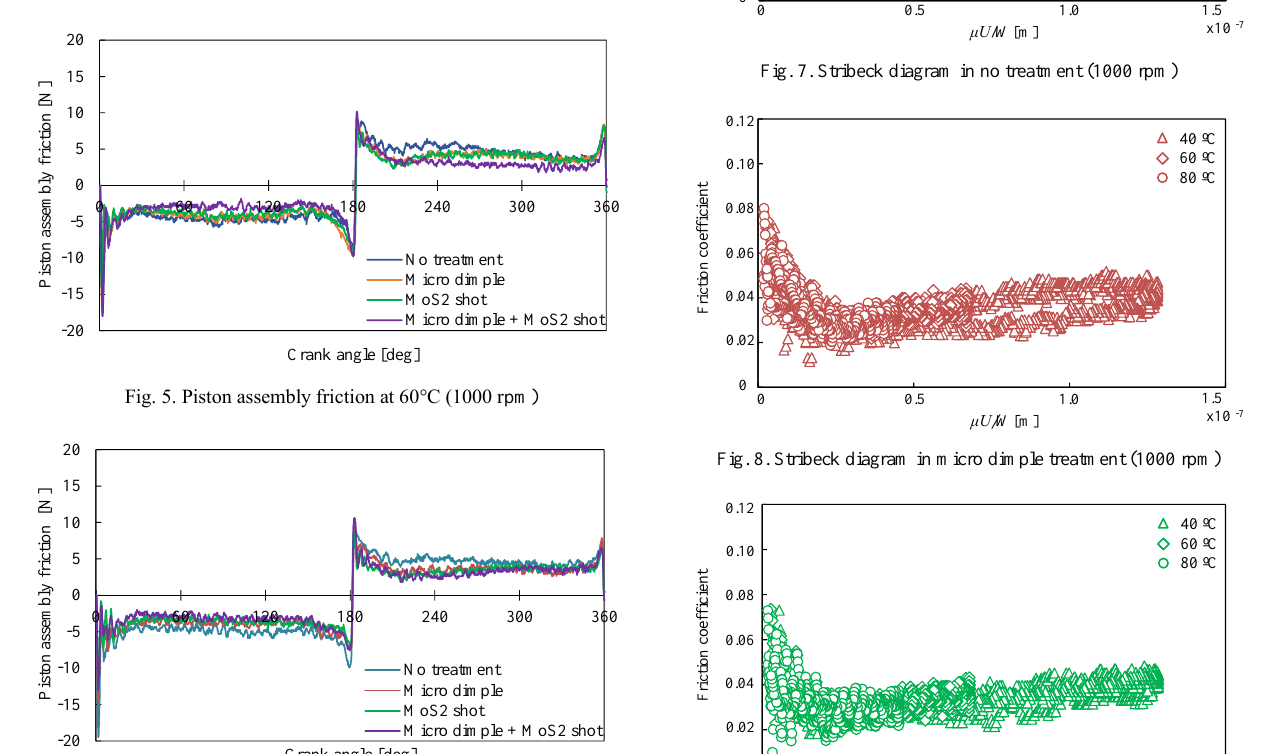
Fig. 4. Piston assembly friction at 40°C (1000 rpm)